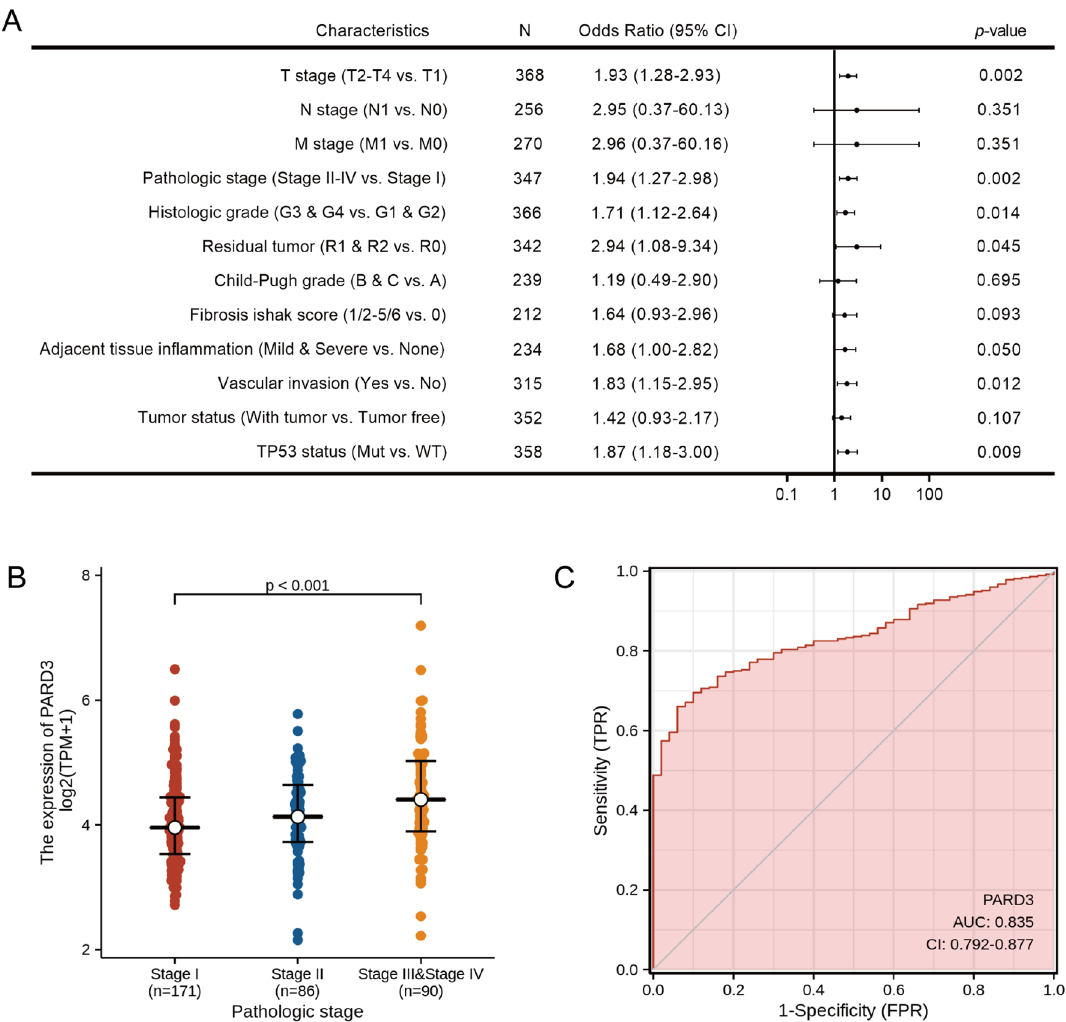
Figure 2. Correlation between PARD3 expression and clinicopathologic characteristics in HCC. ( A ) Correlation between PARD3 expression (categorical dependent variable) and clinicopathologic characteristics (logistic regression; Odds Ratio equals to the ratio of odds high expression to odds low expression ). ( B ) High PARD3 expression (categorical dependent variable) was associated with advanced pathologic stages. ( C ) Time- dependent receiver operation characteristic (ROC) curve of PARD3. False positive rate (FPR) is indicated on the abscissa; and true positive rate (TPR) is indicated on the